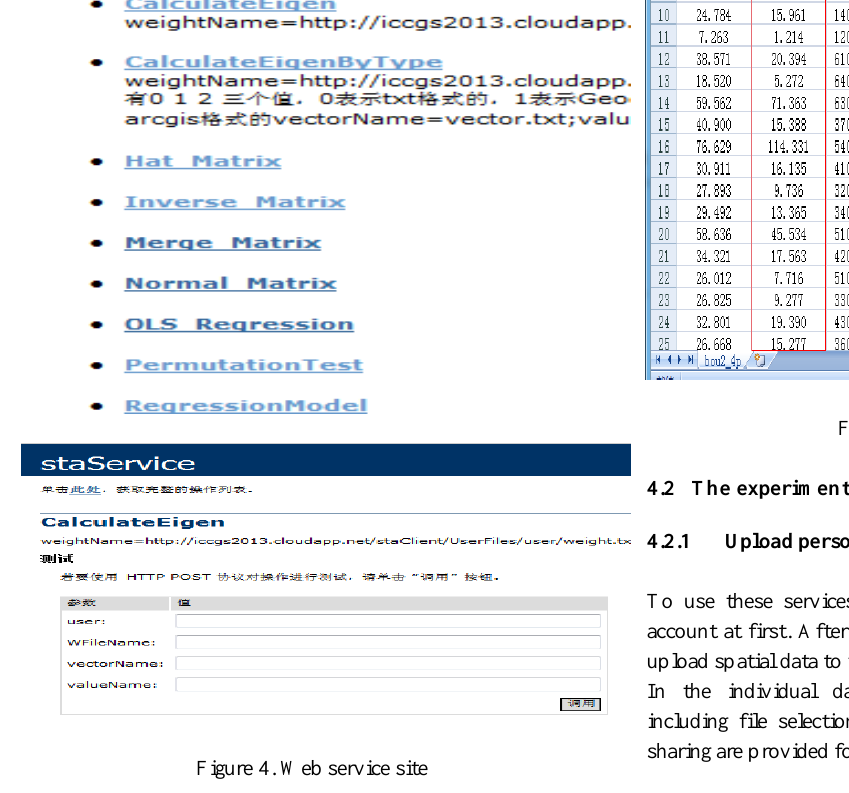
Figure 4. Web service site